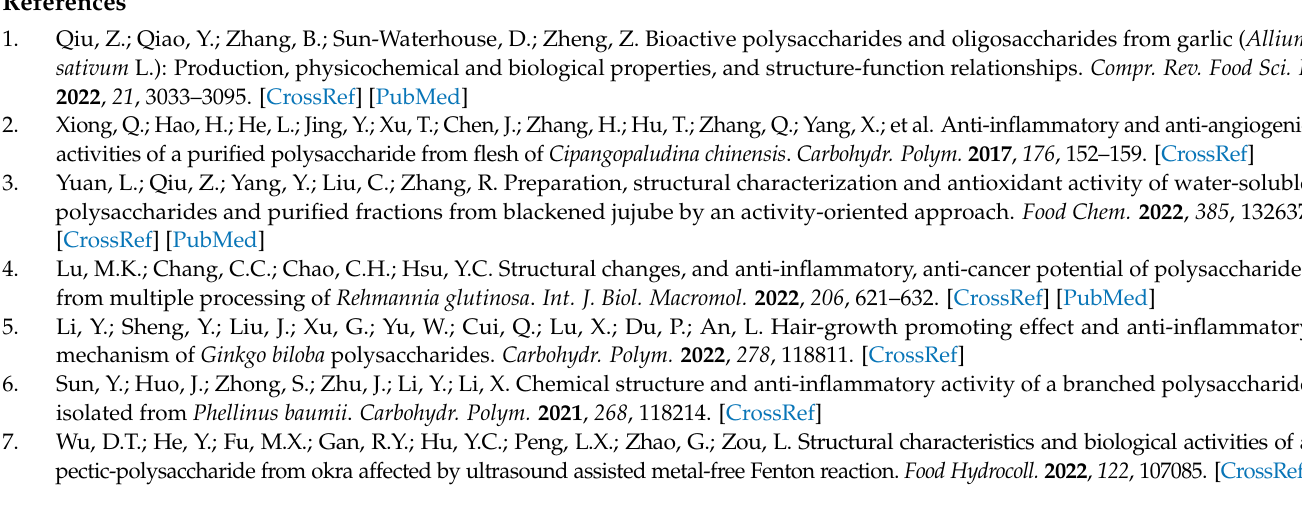
Figure S1: Representative images of zebrafish treated with CuSO 4 , ibuprofen and different doses of GPs and GP–Zn (II)